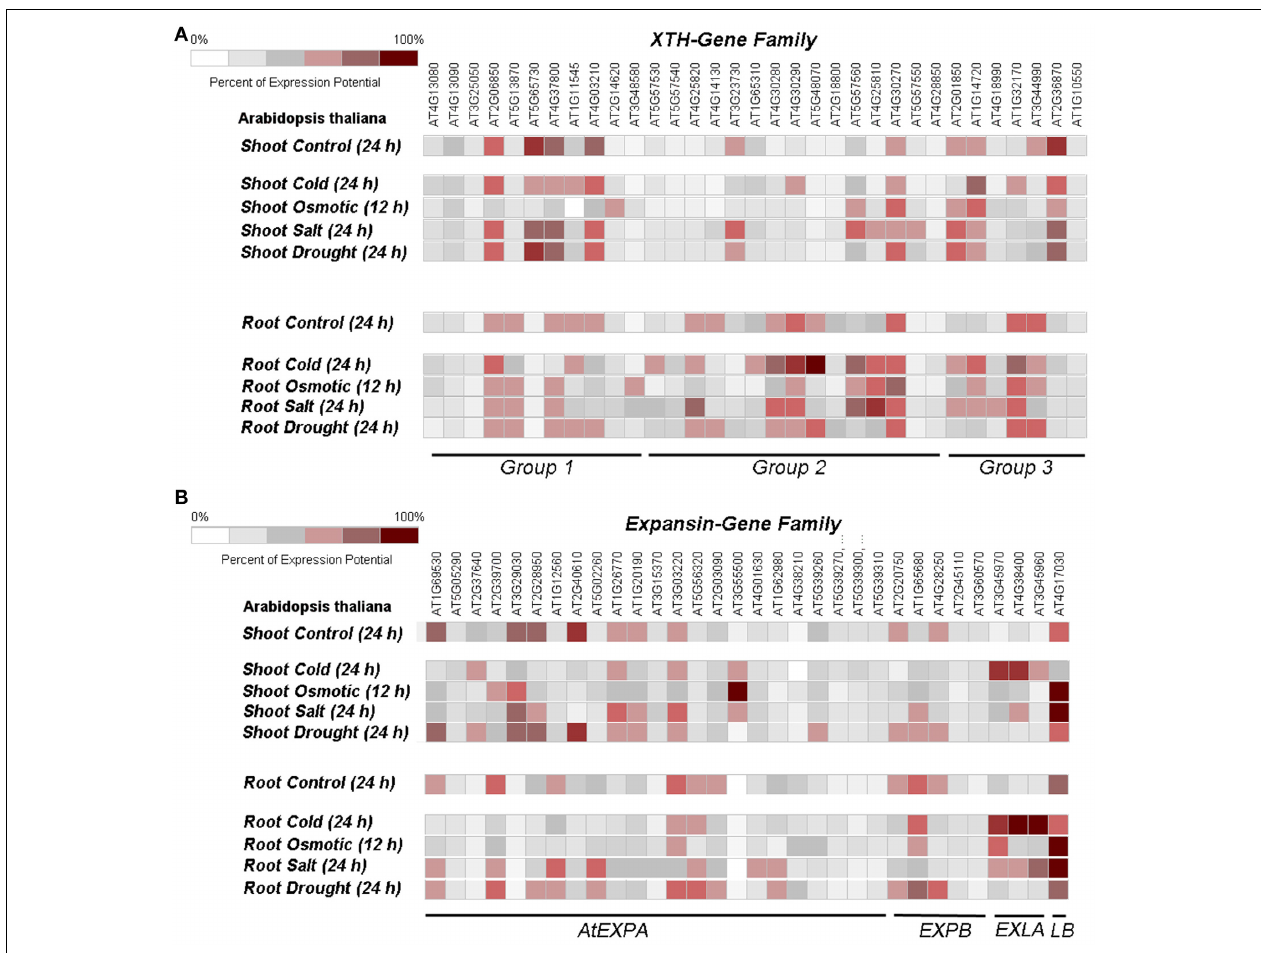
FIGURE 1 | Heat map of expansin and XTH gene expression under abiotic stress for (A) XTH gene family and (B) expansin gene family. The XTH gene family is classified according to Rose et al. (2002), the expansins are classified according to Lee et al.